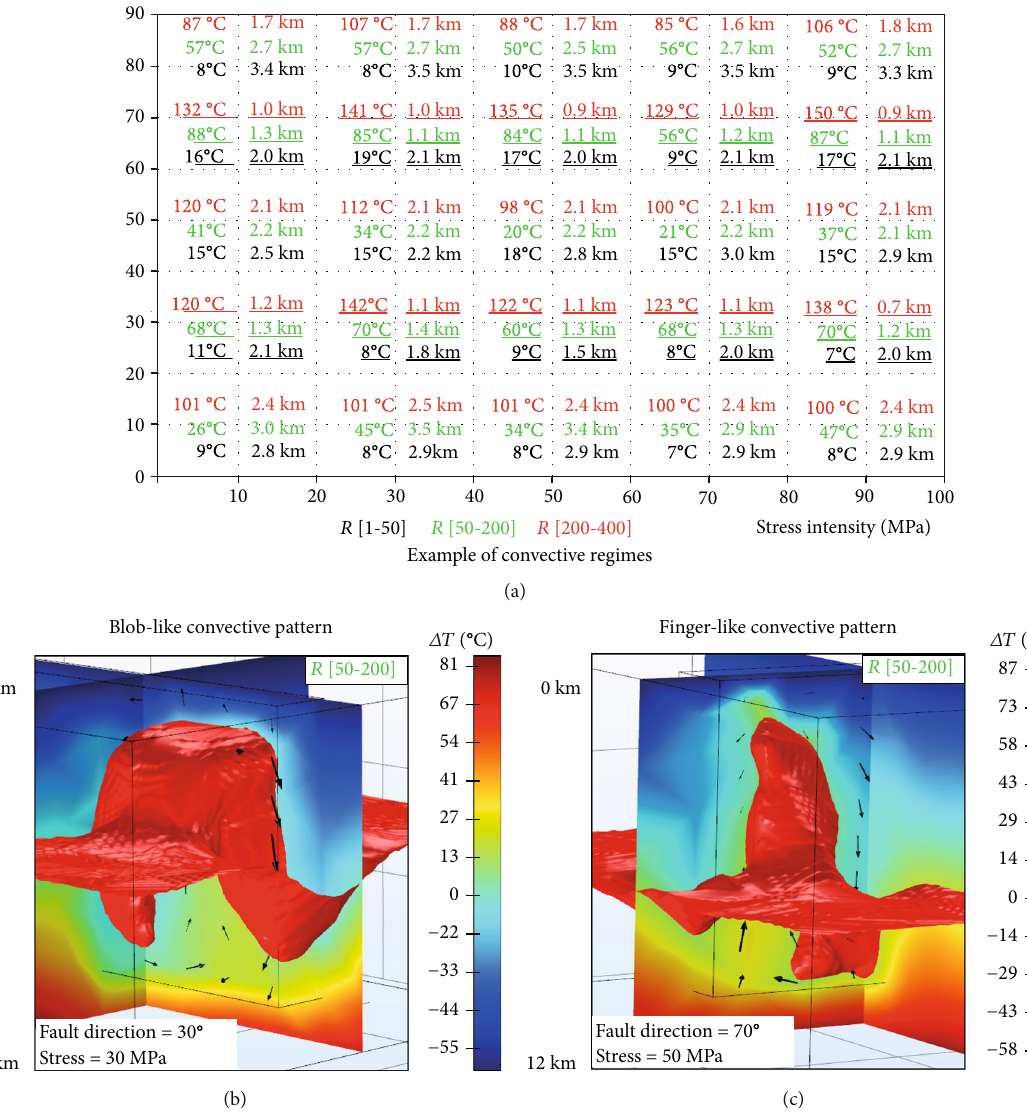
Figure 11: (a) Positive temperature anomalies and their depth for di ff erent permeability ratios (black, green, and red) as a function of fault direction (vertical axis) and stress intensity (horizontal axis). The underlined values show the trends of temperature anomalies and their depths for fault direction of 30 and 70 ° and for di ff erent stress values. (b, c) show the fl uid fl ow for the same R ratio (green), but for di ff erent fault direction and stress. Red surface illustrates the morphology of the 70 ° C isotherm. (b) shows a “ blob-like ” pattern. (c) shows a “ fi nger-like ”